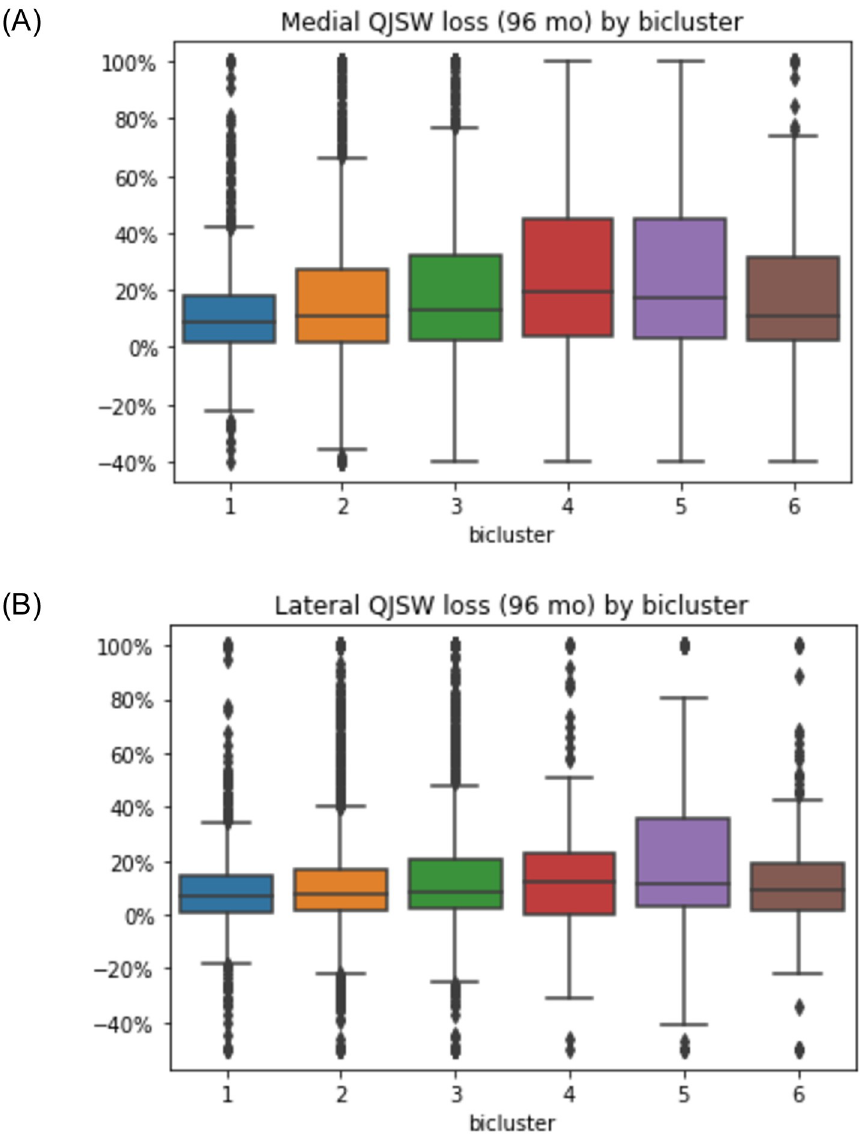
Fig 7. Percentage loss in quantitative joint space width (qJSW) in the medial (A) and lateral (B) compartments for each of the six biclusters on the x-axis.